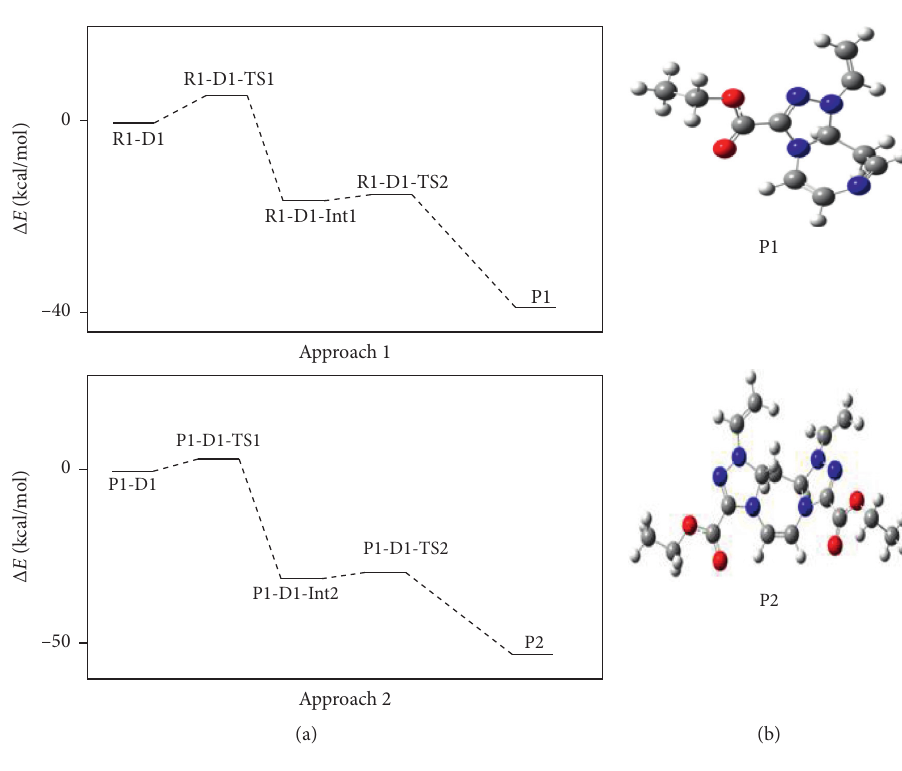
Figure 2: Energetic profile of both approaches at B3LYP/6-31G(d) level (a) and the lowest lying isomers of P1 and P2 products (b).